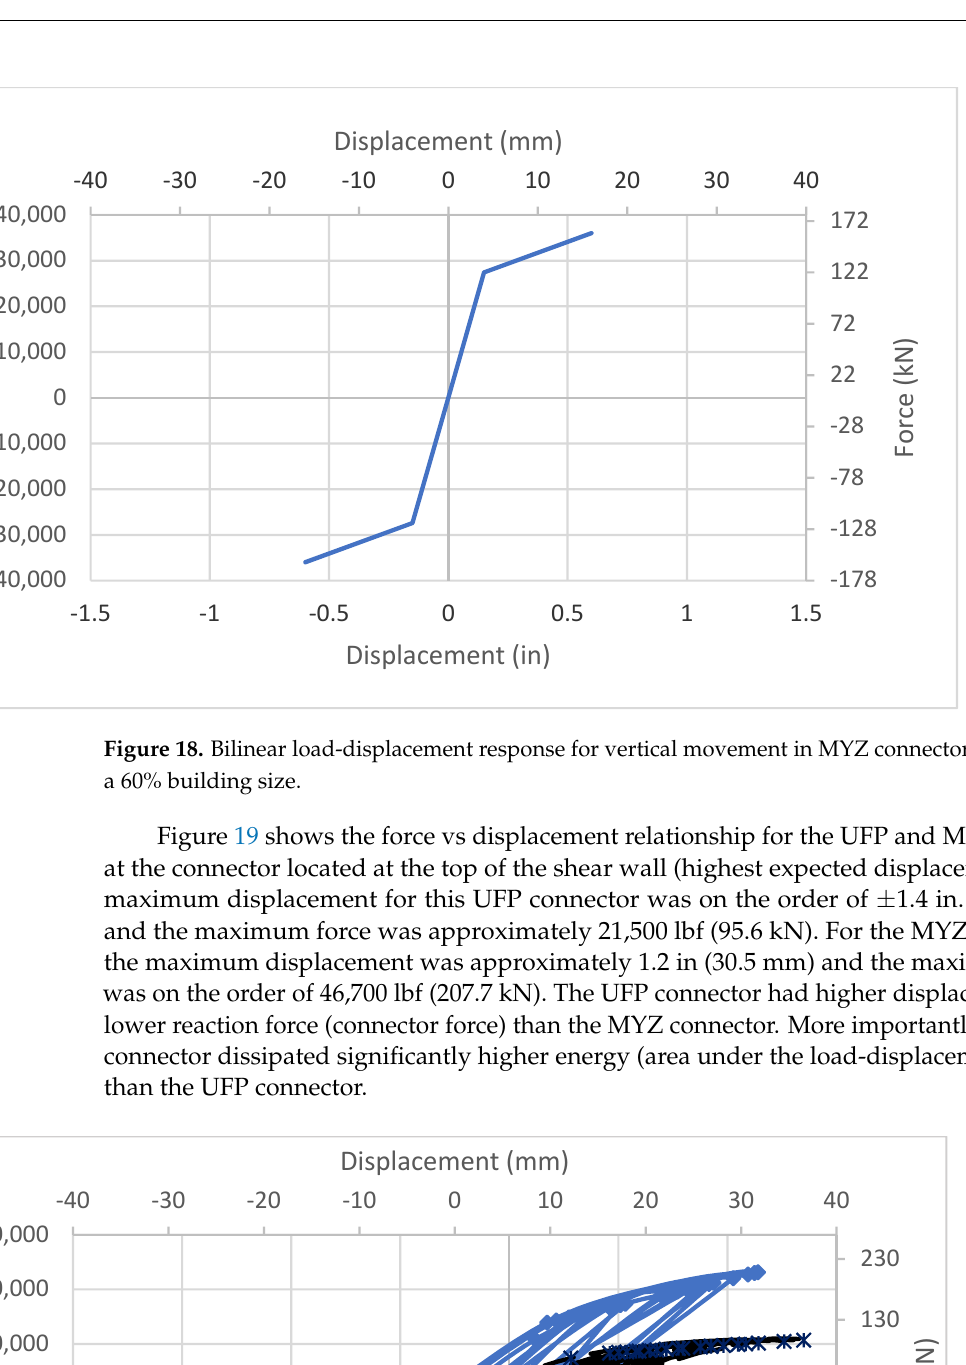
Figure 17. Bilinear load-displacement response for vertical movement in UFP connector—scaled for a 60% building size.